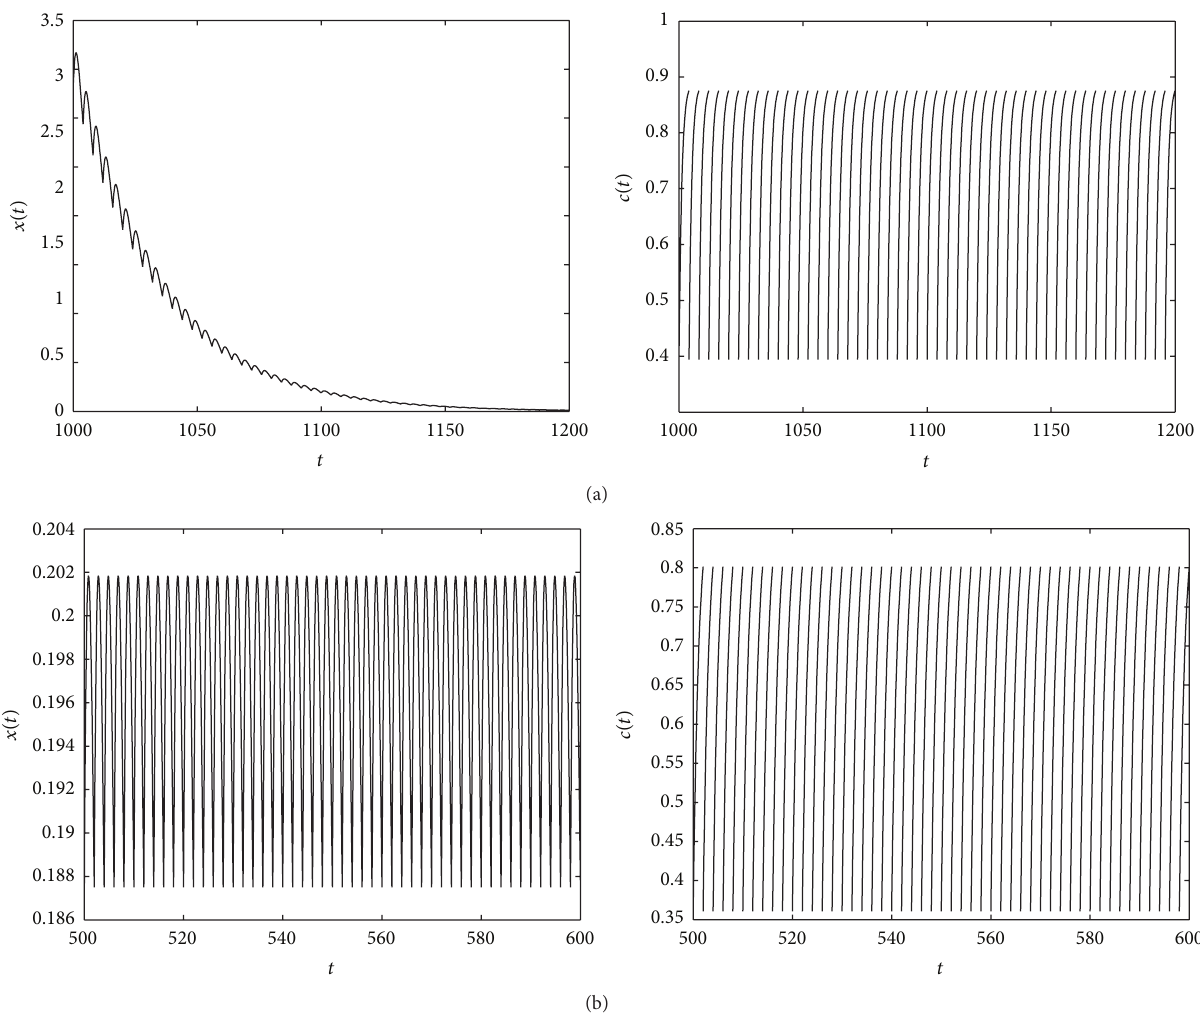
Figure 1: Time series of system (7). (a) Extinction solution of system (7) with parameters 𝑟 = 0.5 ; 𝐾 = 2 ; 𝑟 1 = 0.7 ; 𝜇 = 0.8 ; ℎ = 0.9 ; 𝑇 = 4 ; 𝛽 = 0.55 ; 𝑥(0) = 0.6 ; 𝑐(0) = 0.5 . (b) 𝑇 -periodic solution of system (7) with parameters 𝑟 = 0.5 ; 𝐾 = 2 ; 𝑟 𝛽 = 0.55 ; 𝑥(0) = 0.6 ; 𝑐(0) = 0.5